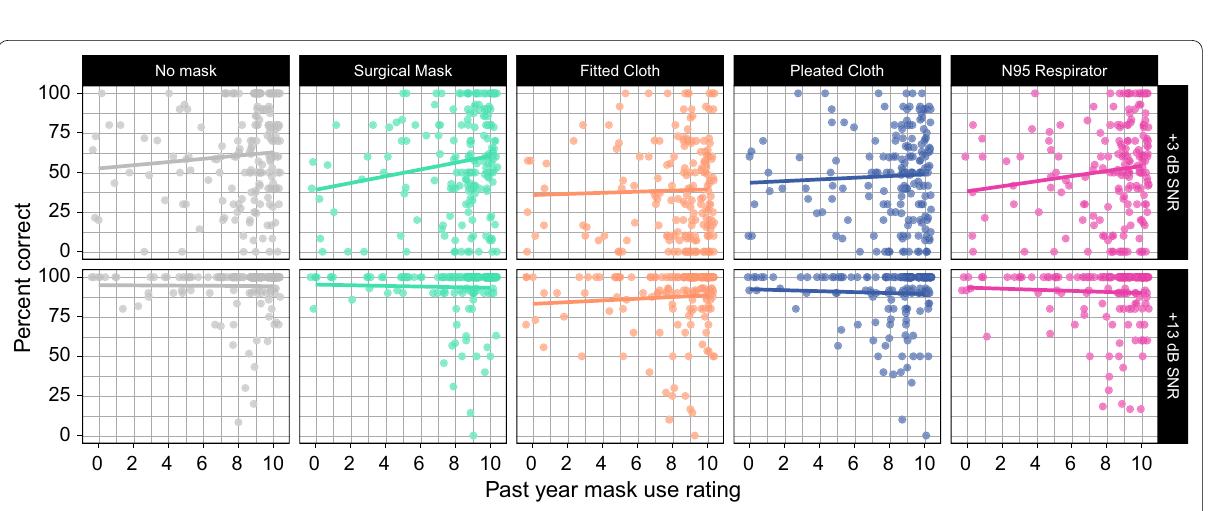
Fig. 4 Same as Fig. 3 for self-reported frequency of the participant’s own mask use in the past